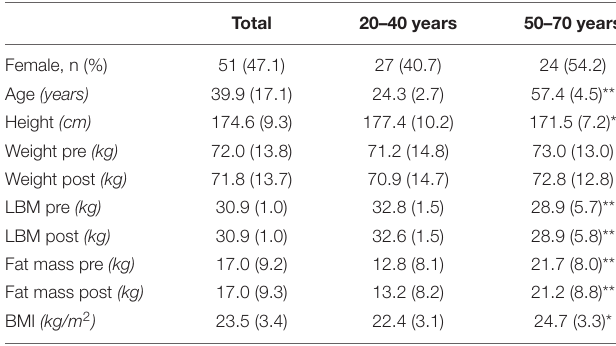
TABLE 3 | Characteristics of participants by age